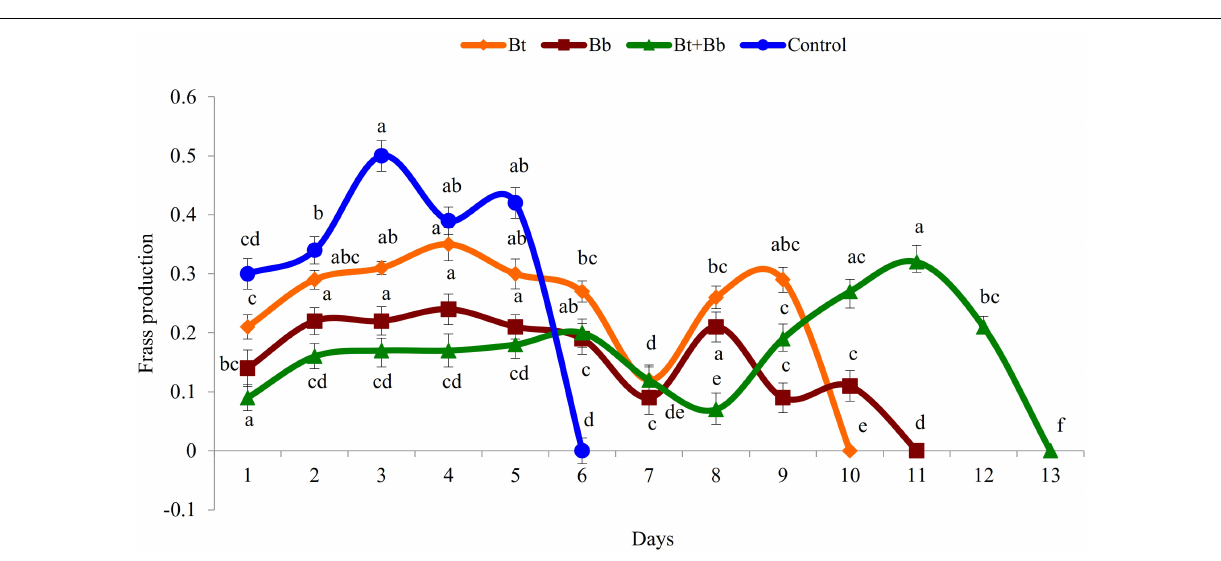
FIGURE 3 | Frass production (g) in last instar H. armigera treated with endophytic B. bassiana (Bb: 1 × 10 5 conidia ml − 1 ) alone and in combination with B. thuringiensis (Bt1: 0.20 µ g ml − 1 ). Means followed by the same letter within each treatment are not significantly different; HSD test P ≤